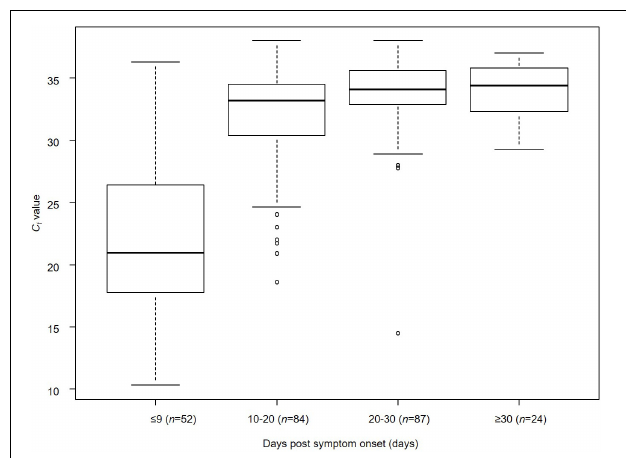
FIGURE 2 | Relationship between days post-symptom onset and C t value of SARS-CoV-2 in Niigata City, Japan, between February and May 2020 ( n = 247). Kruskal–Wallis rank-sum test was used to compare the median values of C t values of RT-qPCR (cycles) by the four categorical variables of time from onset to sample collection ( ≤ 9, 10–20, 20–30, and ≥ 30 days) (days). Bonferroni correction was applied as a post hoc test between each pair. A significant difference in median C t values was observed between the groups ≤ 9 and > 10 days after the onset of symptoms (Kruskal–Wallis rank-sum test, p < 0.001): ≤ 9 days vs. 10–20 days (Bonferroni correction, p < 0.001), ≤ 9 days vs. 20–30 days (Bonferroni correction, p < 0.001), and ≤ 9 days vs. ≥ 30 days (Bonferroni correction, p < 0.001). The lower and upper limits of boxes indicate the 25th and 75th percentiles, respectively; lines within boxes indicate the median values. The lines extending from the boxes indicate the range of non-outlying values. The dots represent individual points that fall outside this range